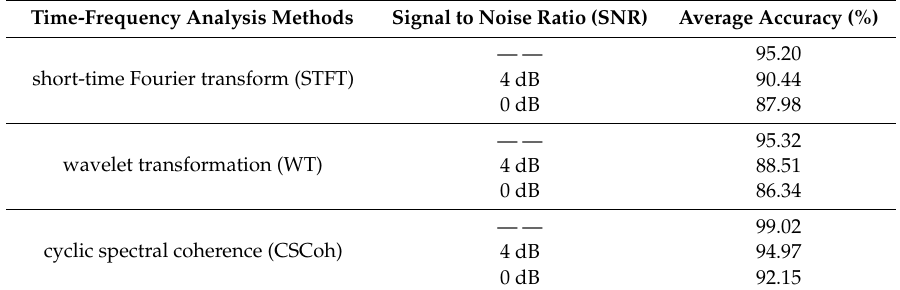
Table 1. Comparison of average accuracy with different time-frequency analysis methods in varying working conditions.